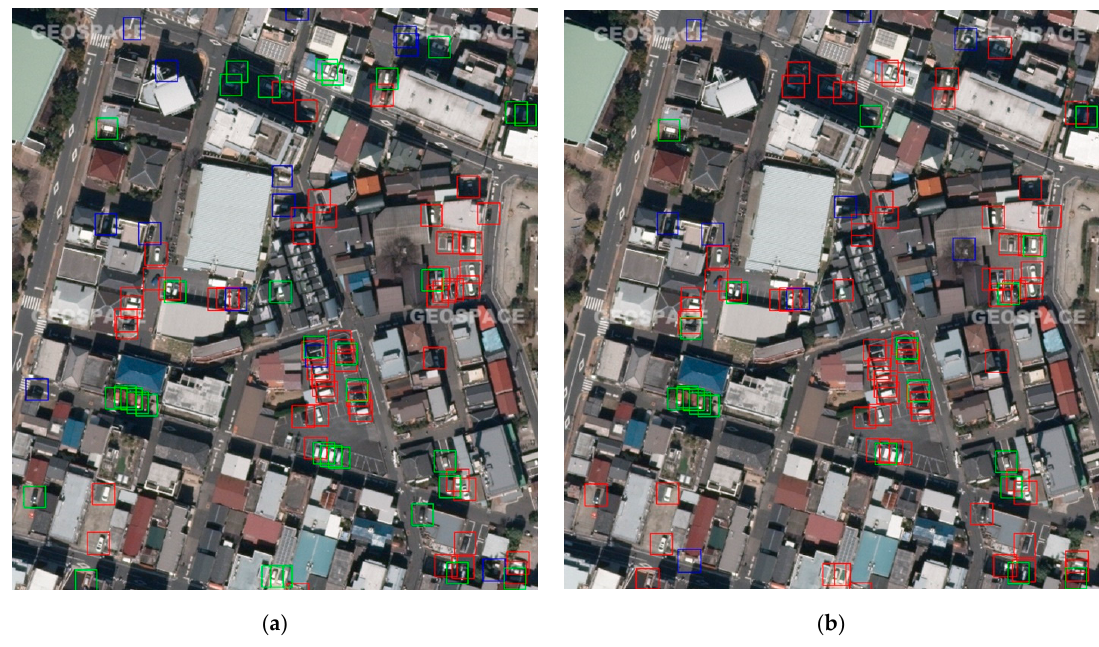
Figure 11. Examples of detection results: ( a ) before applying DA and ( b ) after applying Adv with rec. The red, blue, and green bounding boxes represent true positives (correct detections), false positives (misdetections), and false negatives (undetected groundtruth vehicles), respectively.